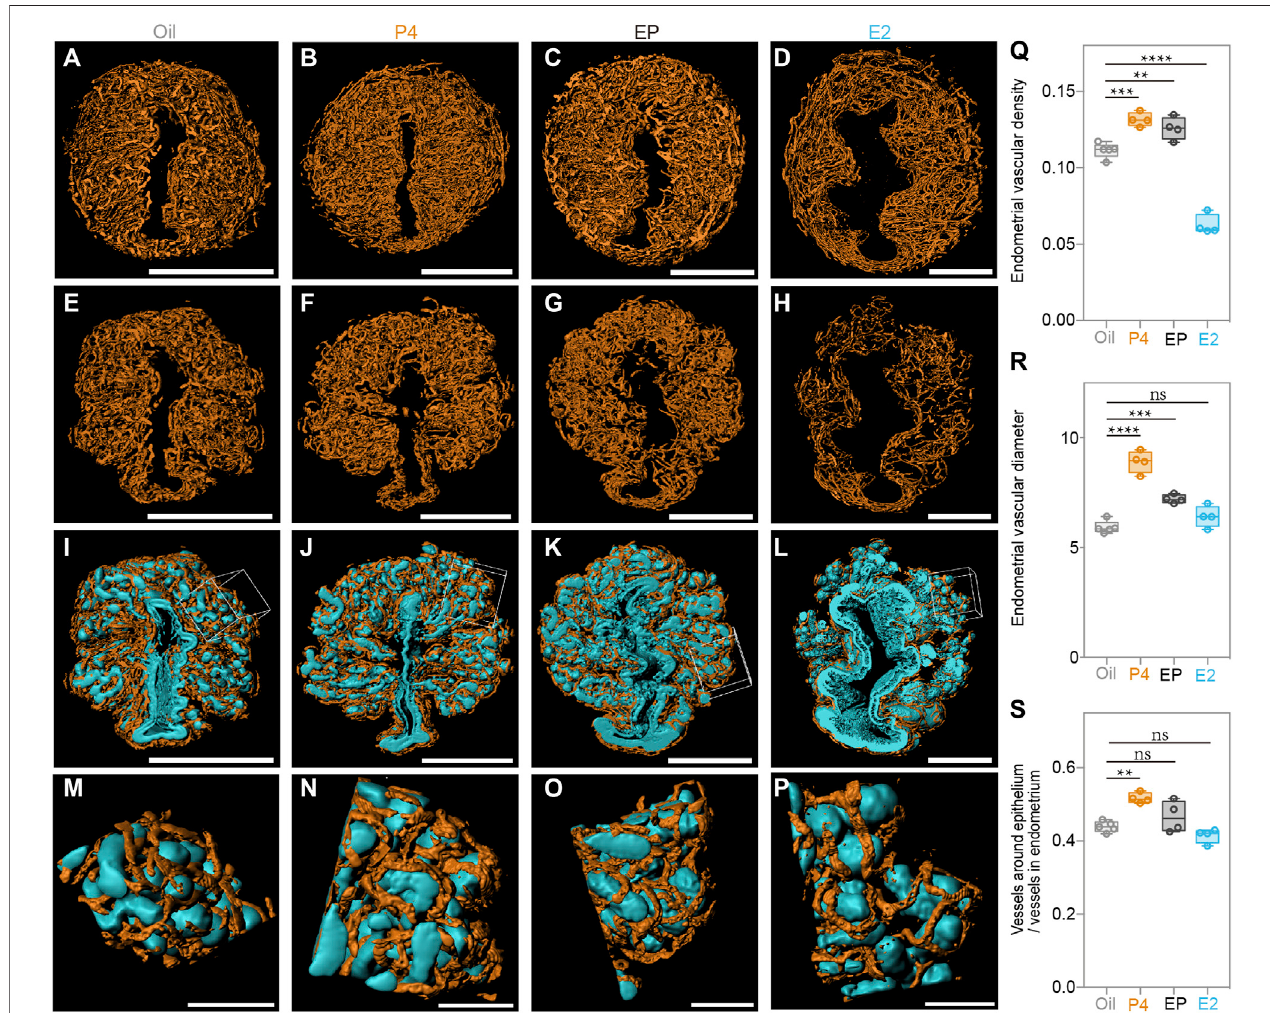
FIGURE 7 | Uterine endometrial angiogenesis in the 3D level after steroid hormone treatment. (A – D) 3D rendering of endometrial blood vessels in the oil-treated group (A) , P4-treated group (B) , E2plus P4 (EP)-treated group (C) , and E2-treated group (D) . (E – H) 3D rendering of the vessels around the epithelium in the oil-treated group (E) , P4-treated group (F) , E2 plus P4 (EP)-treated group (G) , and E2 treated group (H) . (I – L) Blood vessels closely surrounding the epithelium in the oil-treated group (I) , P4-treated group (J) , E2 plus P4 (EP)-treated group (K) and E2-treated group (L) . (M) Magni fi ed details at the boxed area of (I) . (N) Magni fi ed details at the boxed area of (N) . (O) Magni fi ed details at the boxed area of (K) . (P) Magni fi ed details at the boxed area of (L) . (Q) Comparing the endometrial vascular density with differentsteroidhormonetreatments. (R) Comparingtheratioofvesselsaroundtheepithelium/vesselsintheendometriumwithdifferentsteroidhormonetreatments. (S) Comparingtheendometrialvasculardiameterwithdifferentsteroidhormonetreatments.Scalebarof (A – L) =350 μ m.Scalebarof (M – P) =70 μ mTheresultsareshown as means ± SEM. Different letters represent signi fi cant differences ( p < 0.05). * p < 0.05, ** p < 0.01, *** p < 0.001, **** p < 0.0001. n ≥ 4.